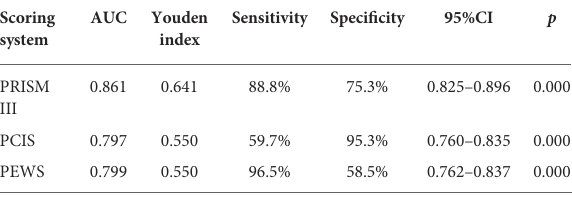
TABLE 4 ROC analysis of three scoring systems for treatment failure of bronchiolitis. Scoring